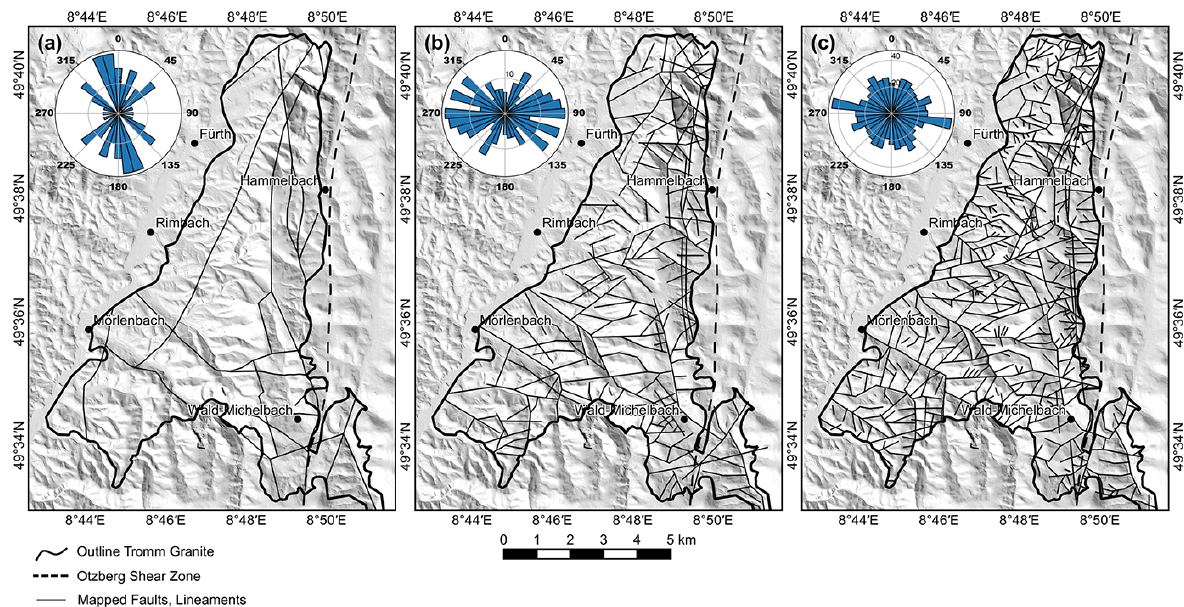
Figure 4. Summary of the lineament analysis in the Tromm Granite area: (a) compilation of mapped faults from various geological maps (modified after Klemm, 1900, 1928, 1929, 1933; HLUG, 2007); (b) regional analysis using SRTM data with 1arcsec resolution (van Zyl, 2001); (c) local analysis using the 1m DEM provided by the HVBG. Table 1. Summary of fracture network properties for all outcrops analyzed in the Tromm Granite